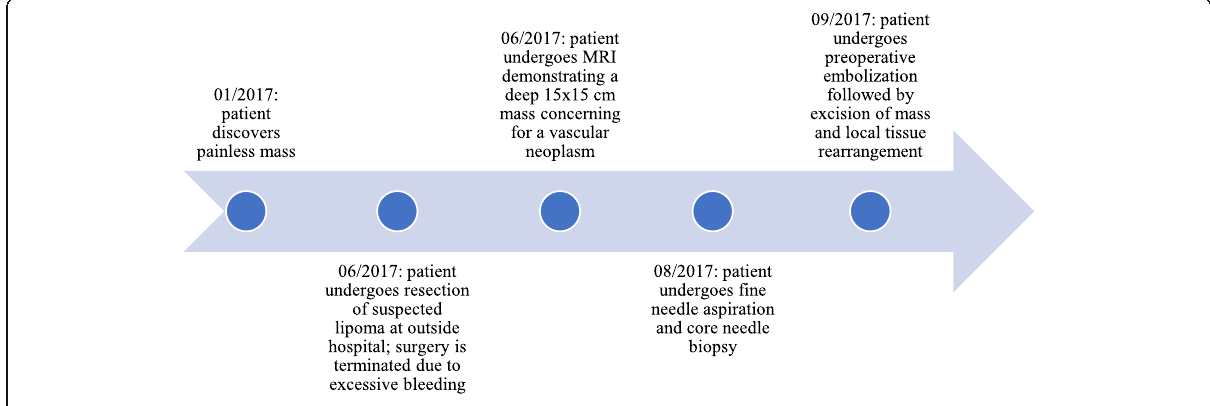
Fig. 3 Timeline delineating the important dates in this patient case from initial observation to surgical management of